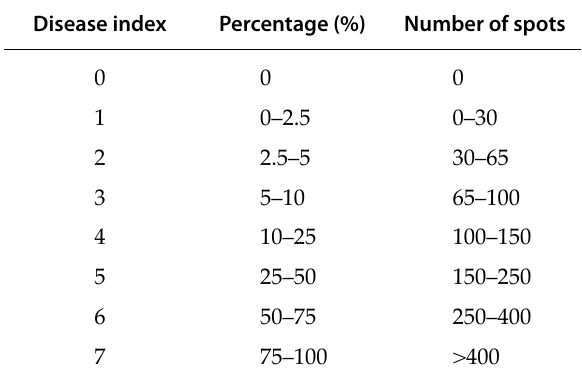
Table 2. Standard disease index of percentage of leaf area infected or number of powdery mildew spots per leaf. Disease